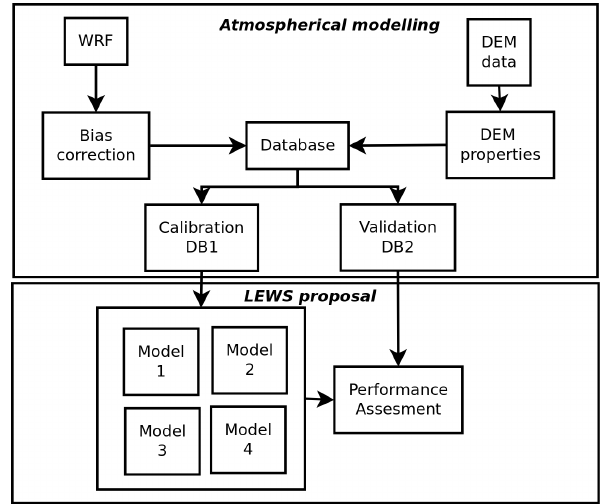
Figure 2. Short methodological description. The first phase is ex- plained in detail in Sect. 3.1, and the second stage is explained in Sect. 3.2 and